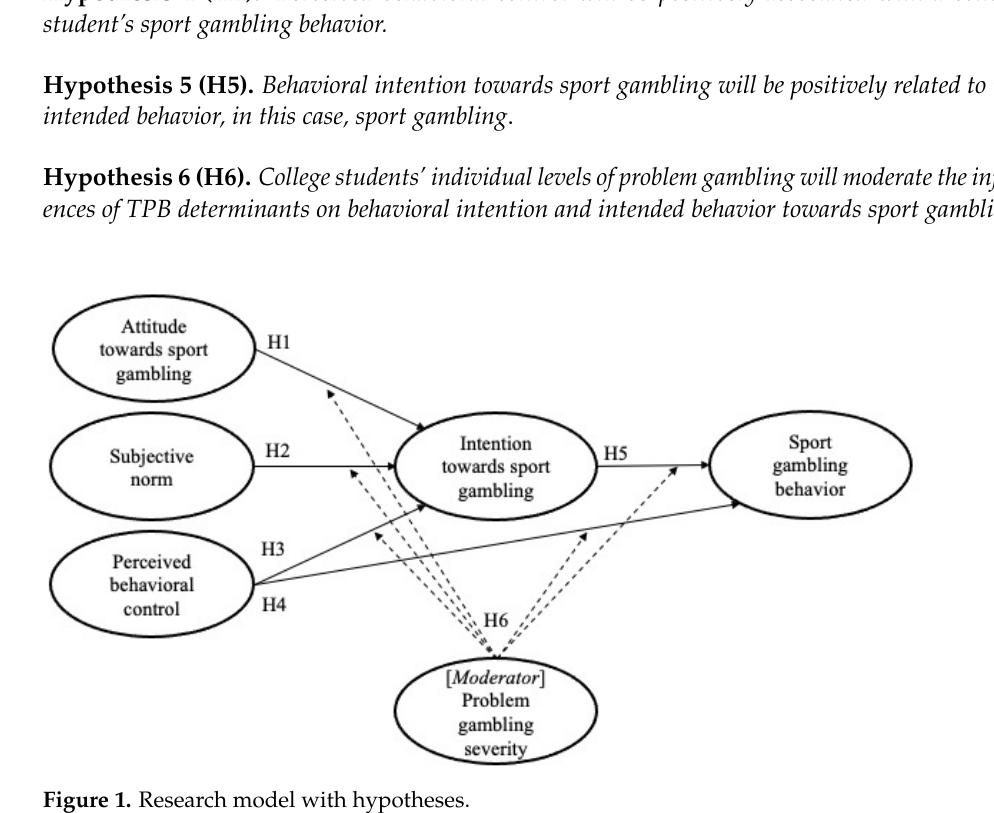
Figure 1. Research model with hypotheses.